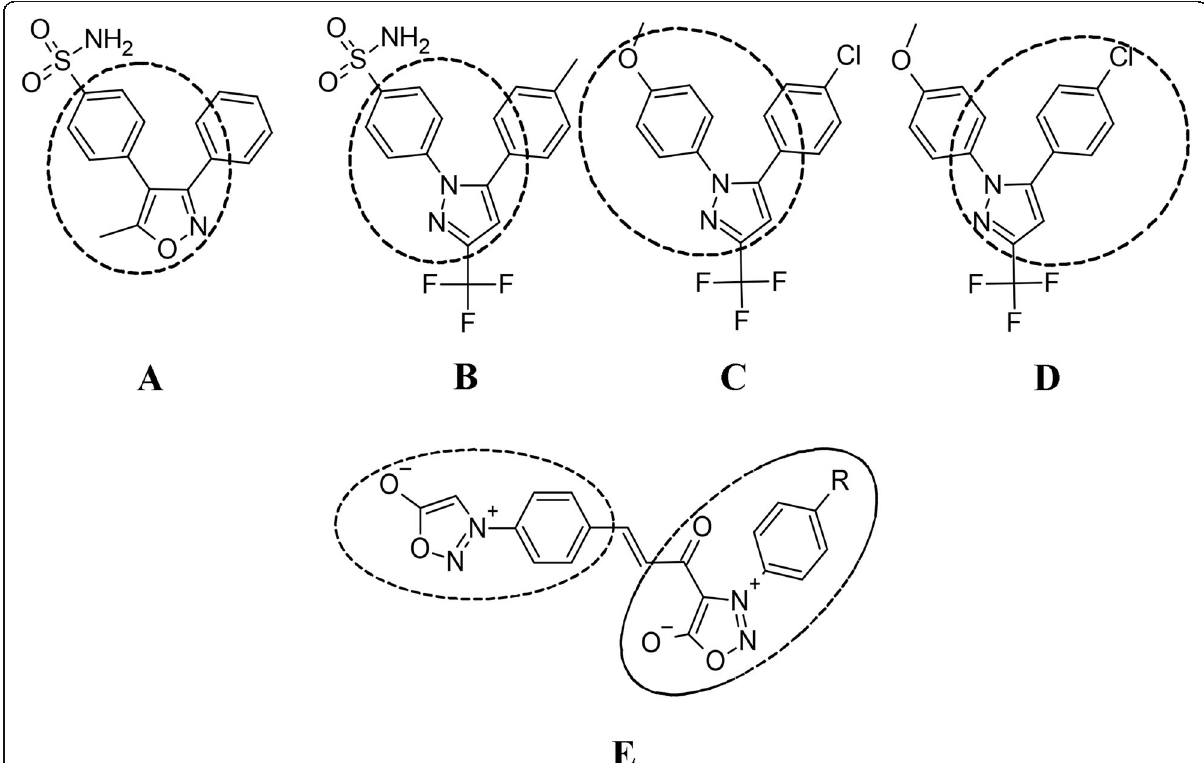
Fig. 9 Structural comparison between coxibs family and bis -sydnone styryl ketones. a valdecoxib, b celecoxib, c , d SC-560, e bis -sydnone styryl ketones 61 – 63 . Dashed circles show the common pharmacophoric features between coxibs and bis -sydnone styryl